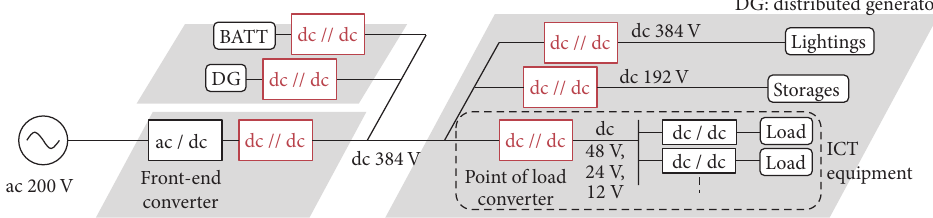
Figure 1: Configuration of next generation dc distribution system for environmentally friendly data centers [1].